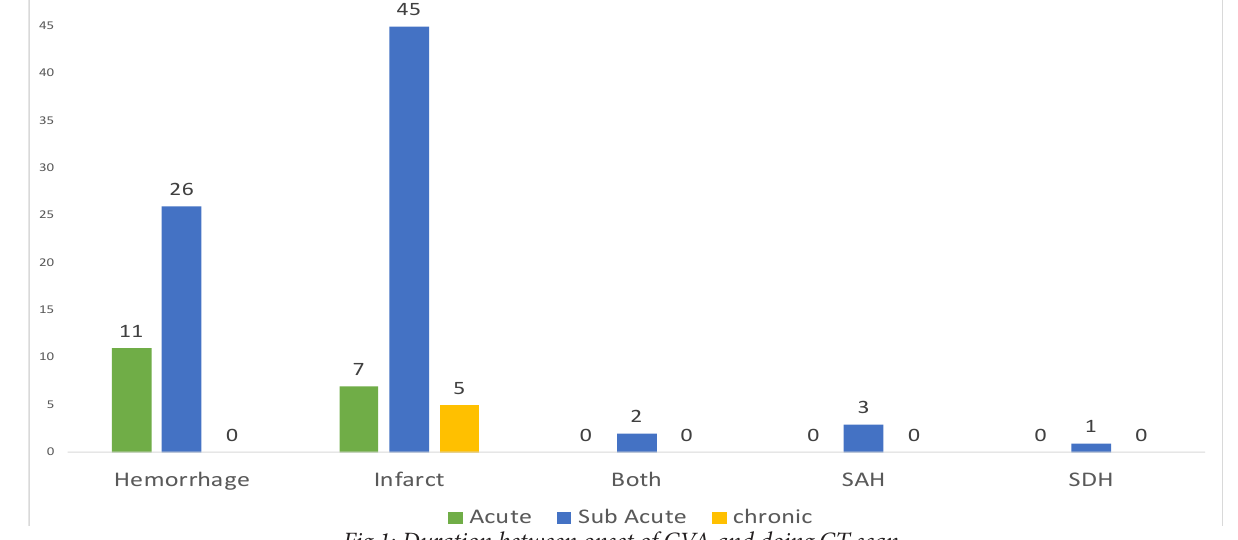
Fig 1: Duration between onset of CVA and doing CT